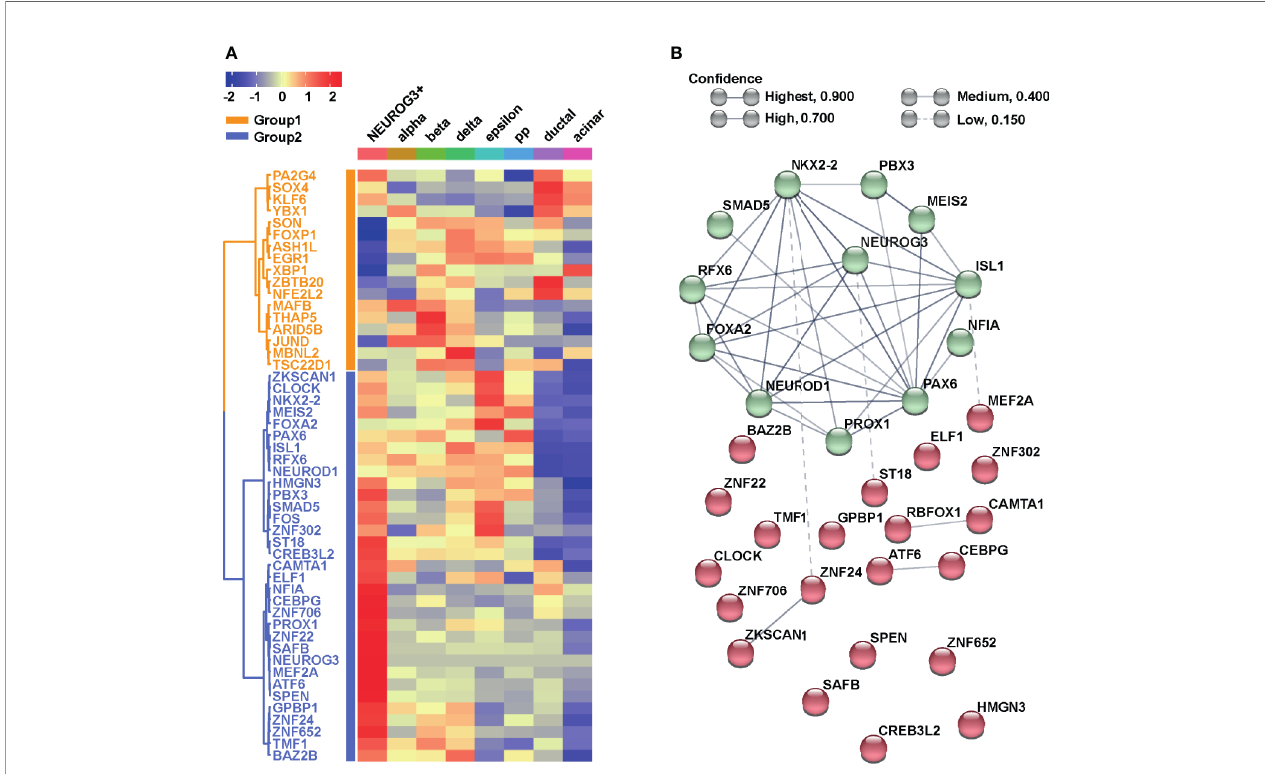
FIGURE 4 | NEUROG3+ cells contain an organized transcriptional network. (A) Heatmap presents the average expressions of the top 50 transcription factors (TFs) expressed in NEUROG3+ cells compared with other cell types, along with hierarchical clustering. (B) STRING analysis displays connectivity of Group 2 TFs. Nodes are colored based on their k-mean cluster memberships. The thickness of connection lines is re fl ective of the strength of data supporting the